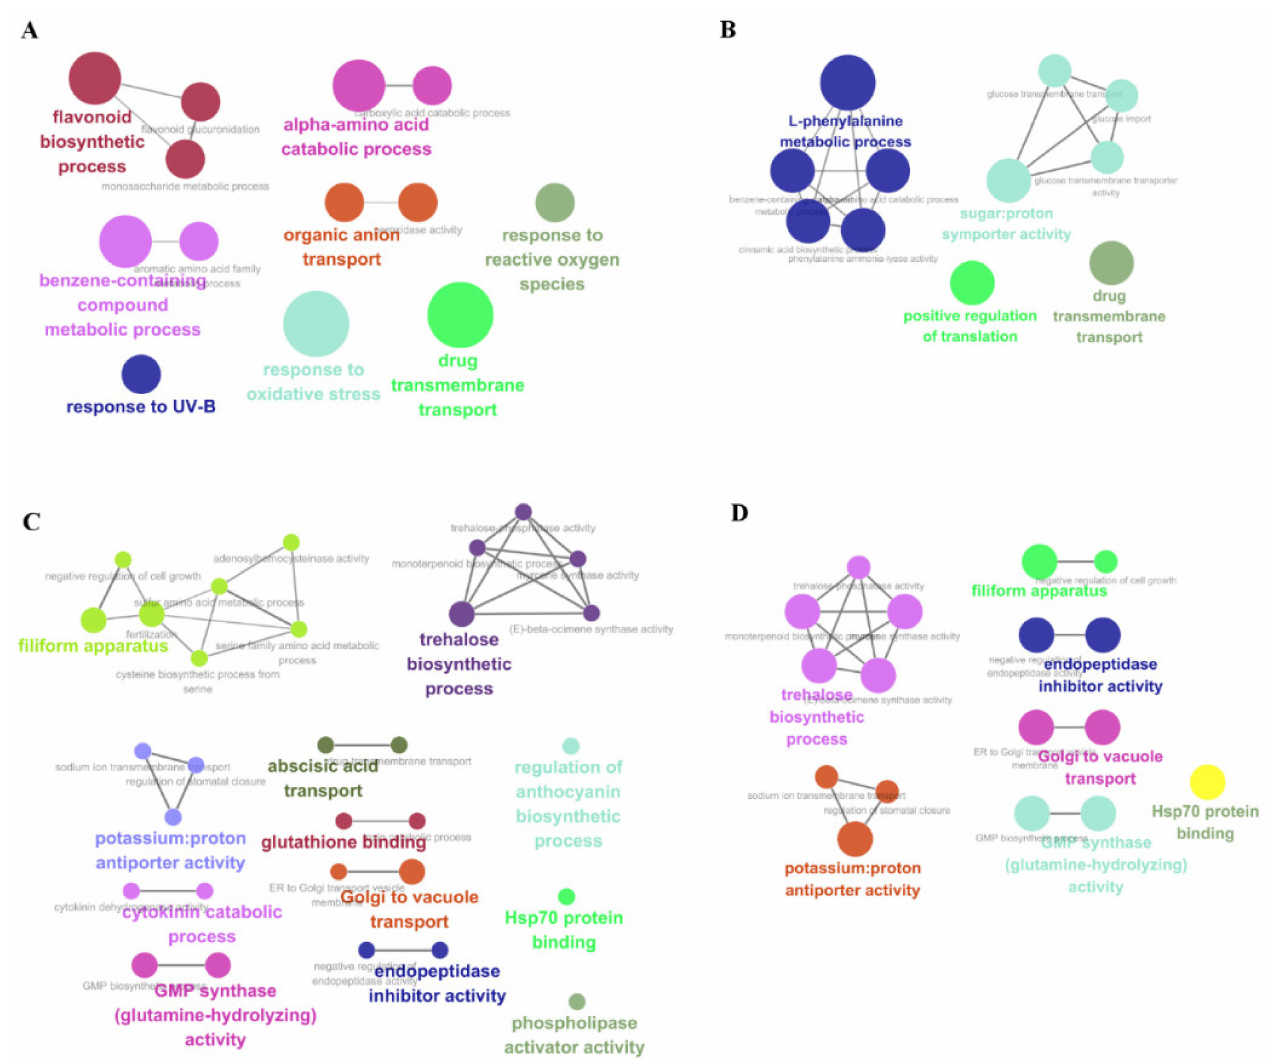
Figure 1. Network analysis of ( A ) DEGs group-I; ( B ) II; ( C ) III; and ( D ) IV. Analysis shows specific gene ontology (GO) categories enrichment of DEGs that showed higher expression in ‘Woori’ compared to